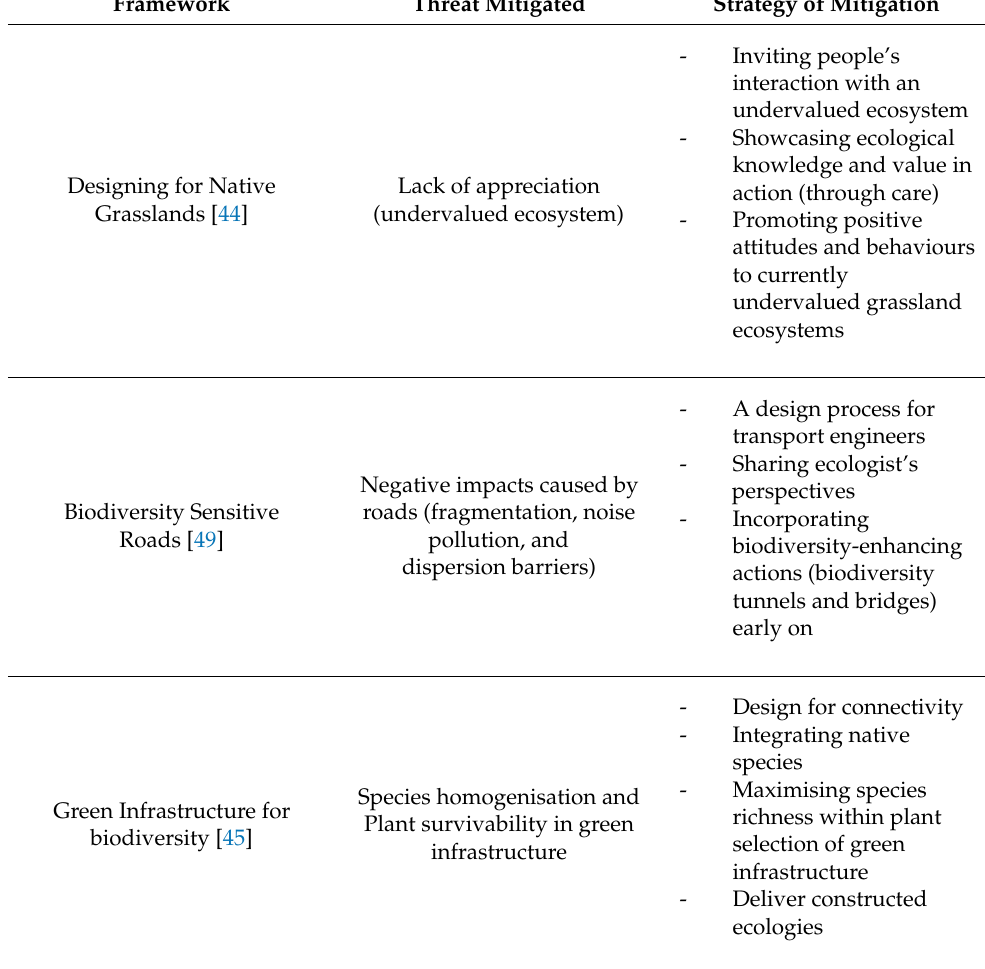
Table 3. Threat mitigation frameworks for minimising the impact of development on target species or